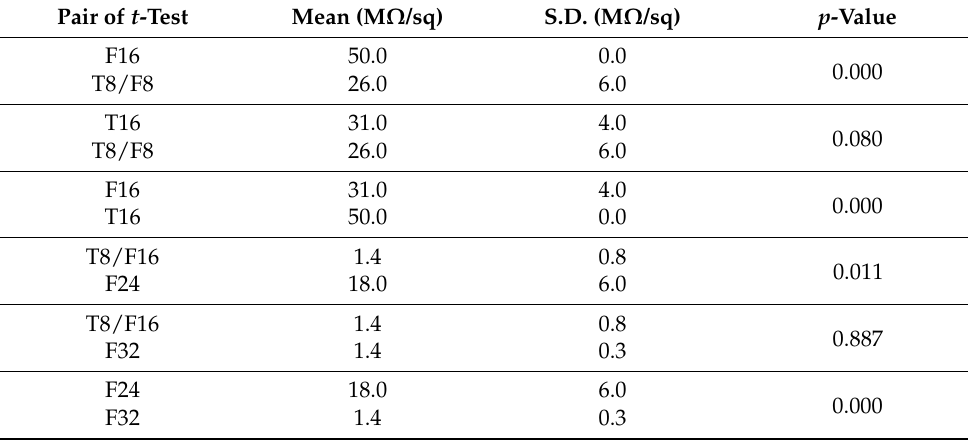
Figure 10. Resistance of the PAN-based conductive yarn with various carbon nanomaterial contents. Table 10. Results of the paired t -test analysis of PAN-based composite fibers with various types of carbon nanomaterials and contents.